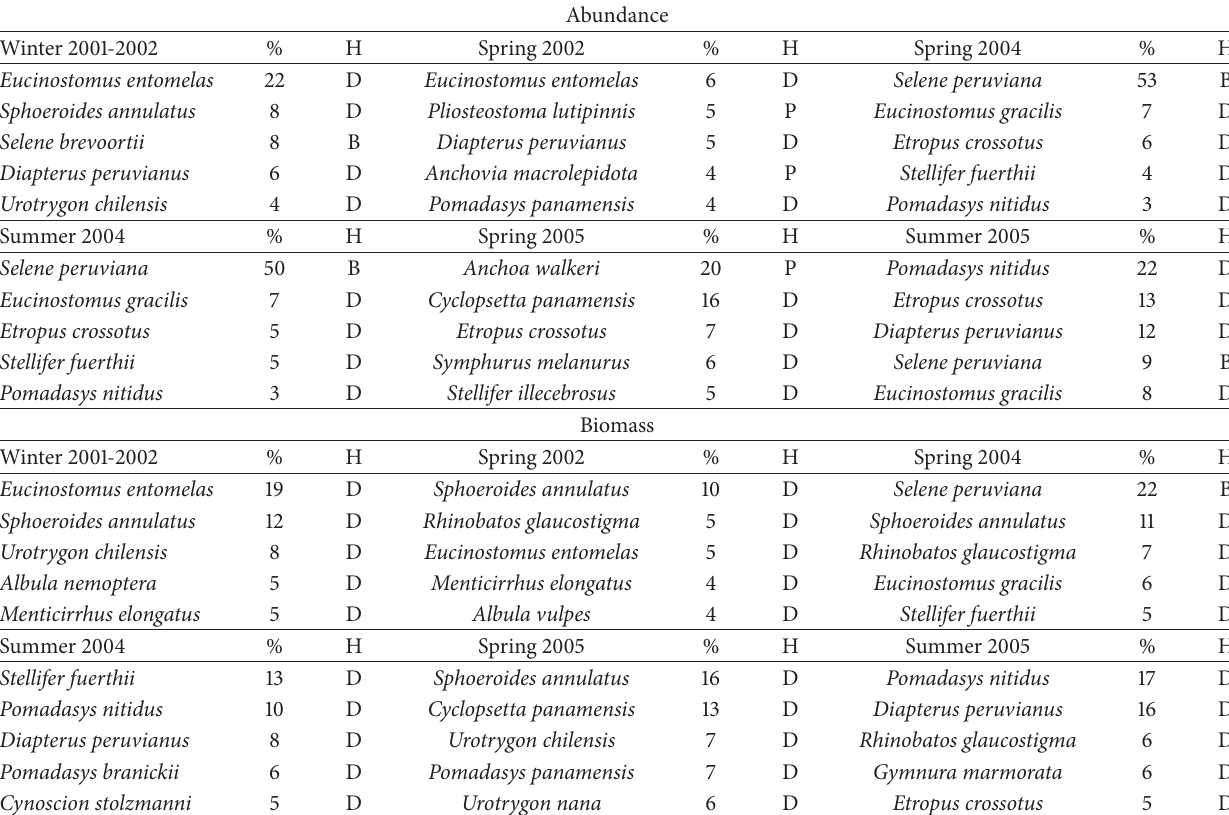
Table 2: Percentage of the top five species in terms of abundance and biomass in each sampled season and its known habitat (H) [27]